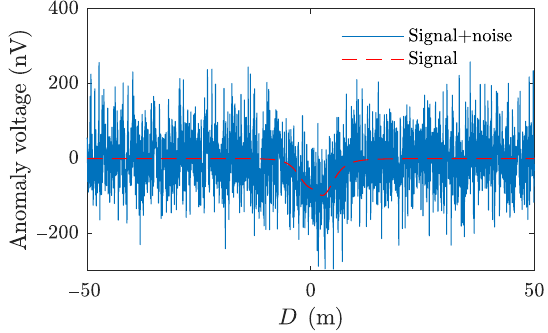
Figure 5. Electric anomaly signal with Gaussian white